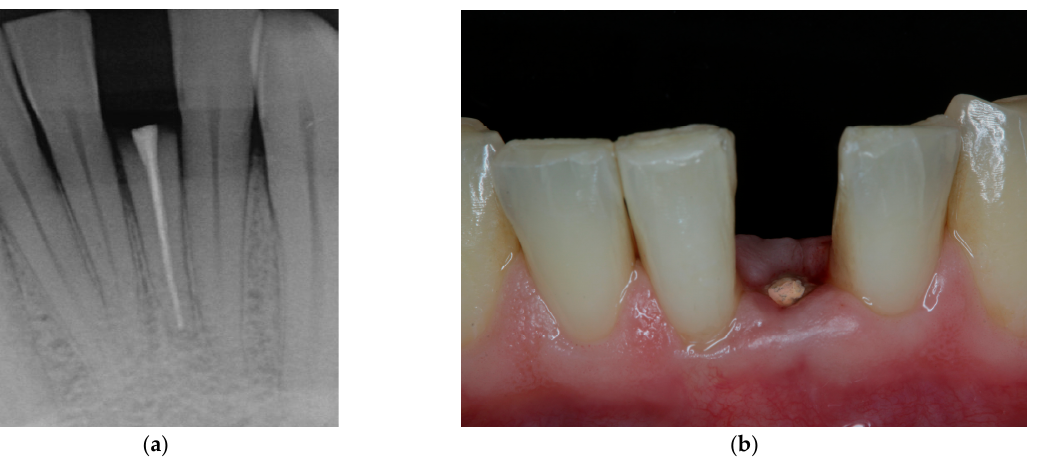
Figure 5. Initial clinical situation showing extensively damaged, anterior tooth in lower jaw. ( a ) Radiographic image at baseline. ( b ) View from buccal aspect shows subgingival defect extension. Restoration without pre-prosthetic treatment measures is not possible as ferrule design may not be achieved and biologic width is violated.